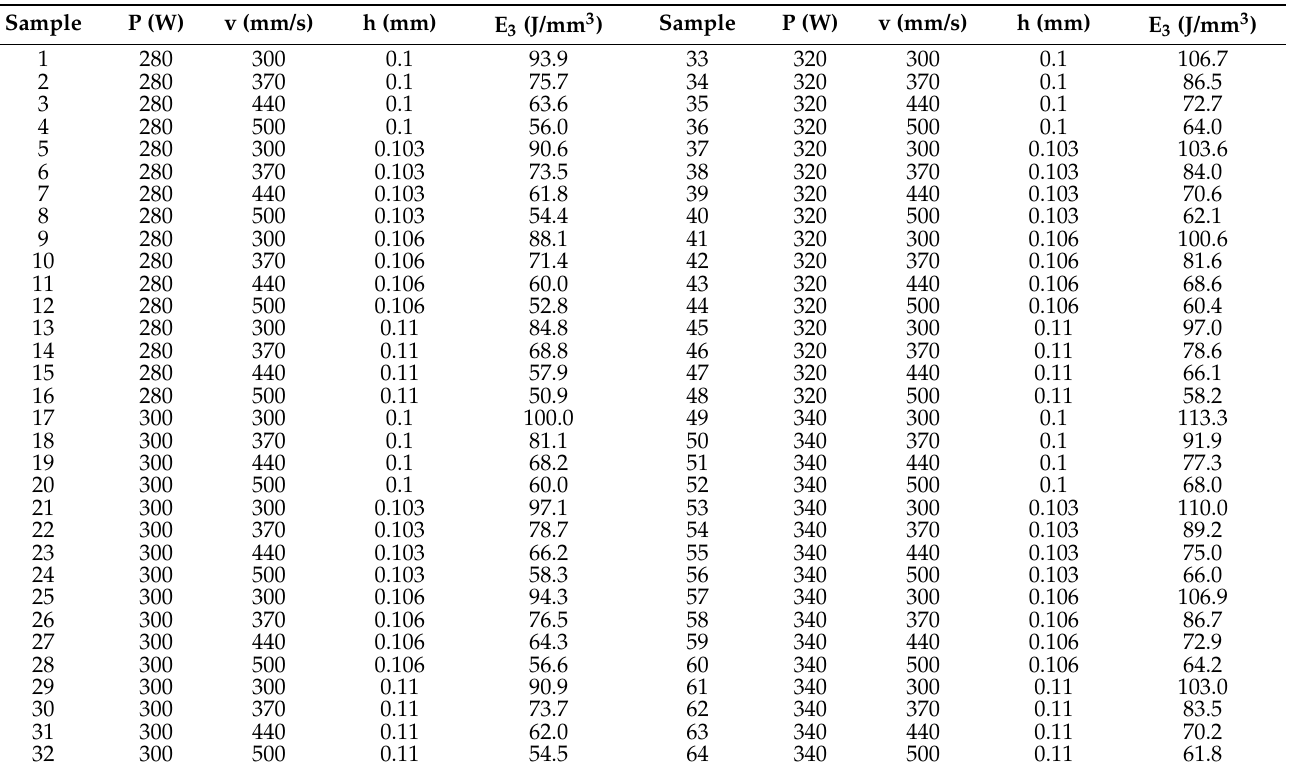
Table 7. Design of a matrix of process parameters after considering the results from the previous step. Sample